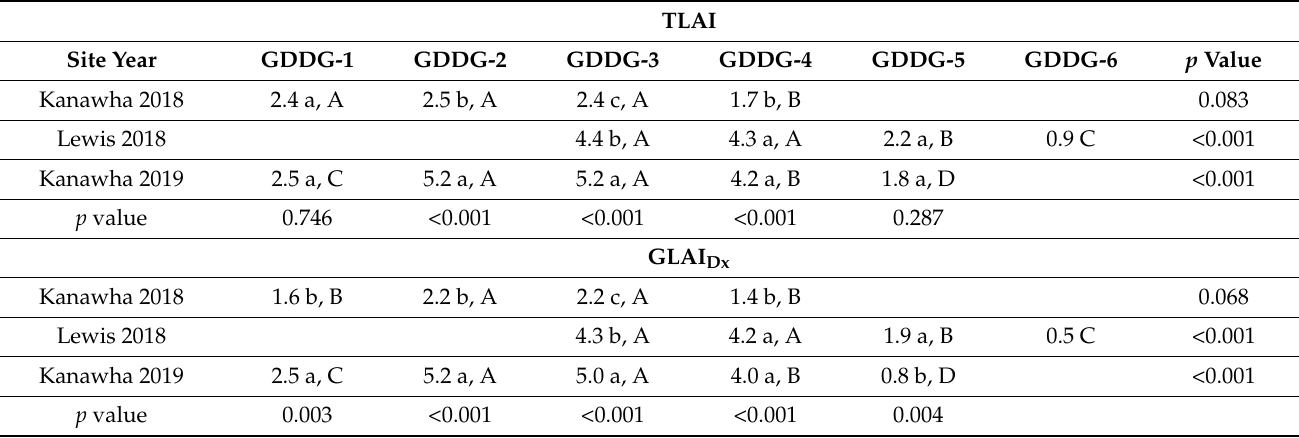
Treatment did not have a significant effect on either TLAI or GLAI Dx (Table 2). Among the treatments, TLAI ranged from 2.8 to 3.0 while GLAI Dx ranged from 2.5 to 2.6. The effect of GDDG was significant for both TLAI and GLAI Dx . TLAI and GLAI Dx both plateaued on GDDG-3 at 4.0 and 3.8, respectively (Table 5). Leaf area begins to decline following GDDG-3. The overall values of TLAI and GLAI Dx for Kanawha 2018 did not surpass 2.5 and 2.2, respectively (Table 8). The Kanawha 2019 location had the highest TLAI value on GDDG-2 and GDDG-3 (around 5.2), approximately 16% more than the next-highest value from Lewis 2018 on GDDG-3 (Table 8). Table 8. Least square means y of the total leaf area index (TLAI) and the green leaf area index with frogeye leaf spot severity removed (GLAI Dx ) measured from experiments in Iowa during 2018 and 2019 z .